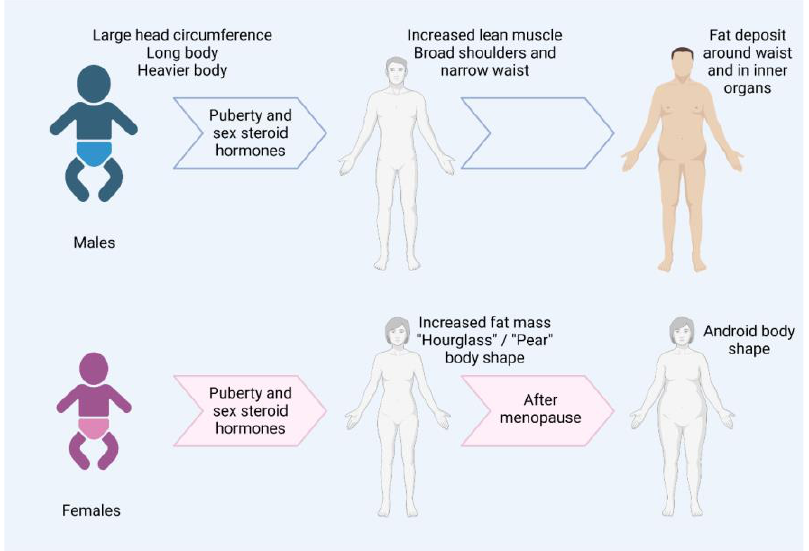
Figure 1. Sexual dimorphism of body shape during life according to findings of several research studies [12–14]. Male babies have larger head circumferences than females, as well as longer bodies, and they are heavier. During puberty, sex-steroid hormones differentiate fat distribution between the two sexes. Men have increased lean muscle and a body shape characterized by broad shoulders and narrow waists. Women have increased fat mass and “hourglass” or “pear” body shapes. Later in life, men deposit fat around the waist and in inner organs, while women tend towards an androgenous body shape. Created with